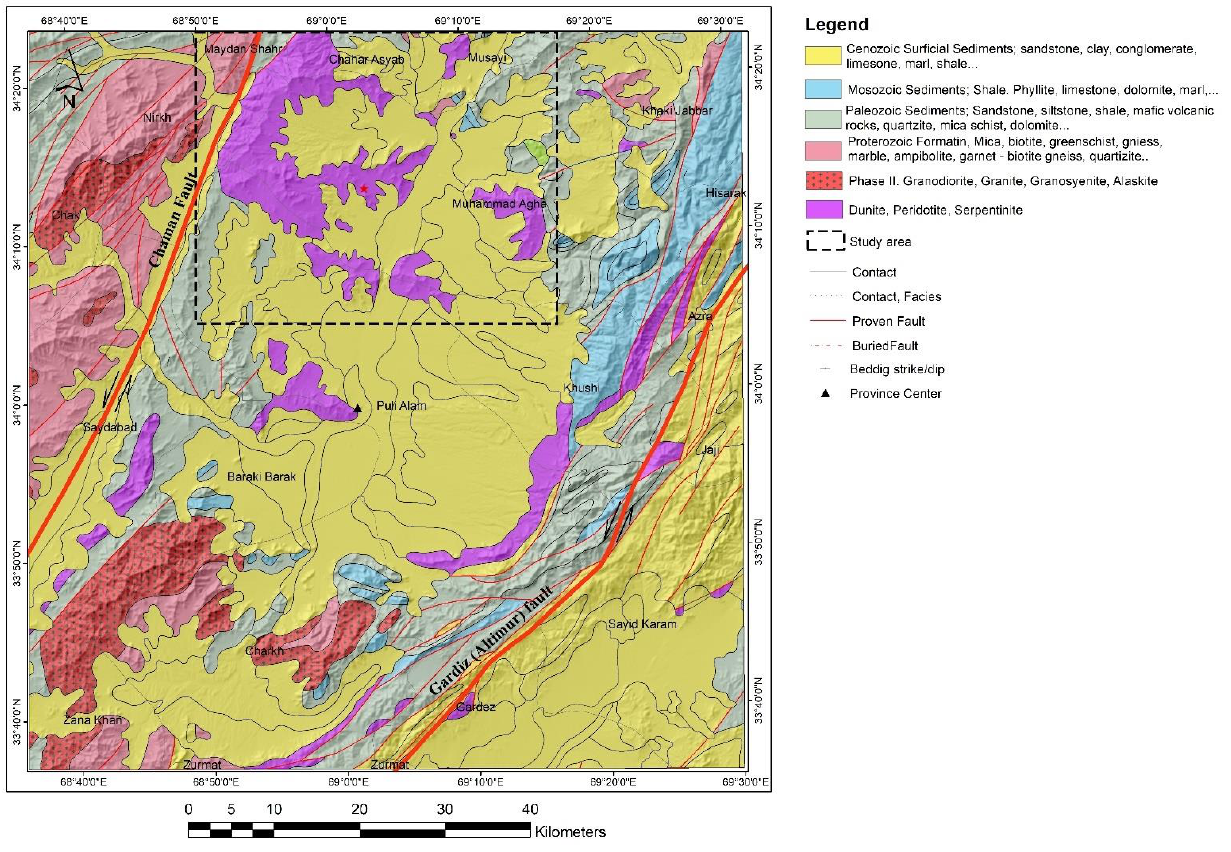
Figure 2. The regional geological map illustrating the geology of the study area on a scale of 1:500,000 modified after [5,8]. modified after